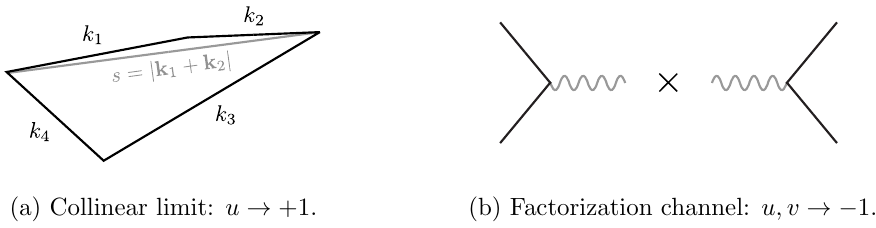
Figure 4. Illustration of two important singularities of the solution ^ F ( u; v ). The singularity in the collinear limit should be absent for the adiabatic vacuum. The singularity in the factorization channel is an avatar of the standard factorization of the scattering amplitude and therefore expected to be